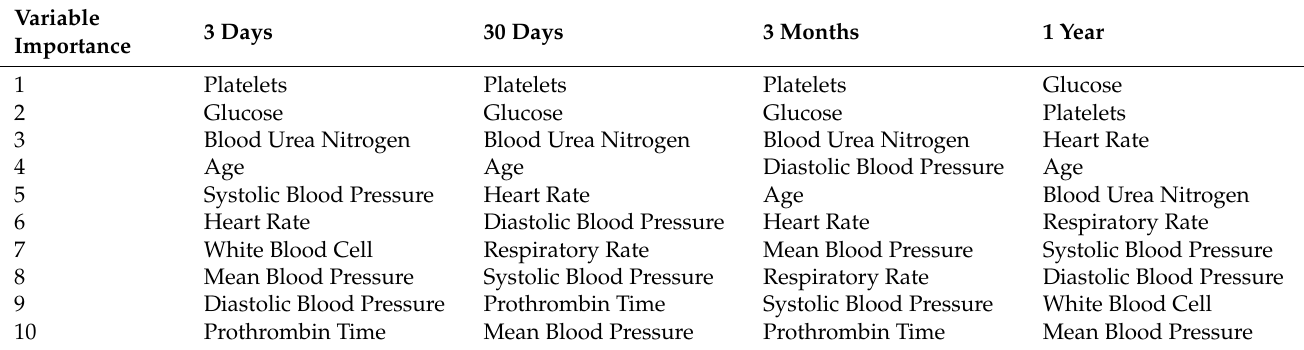
Figure 6. The contribution of the first 20 important variables by using LGBM. Table 6. The selected ten important variables by using